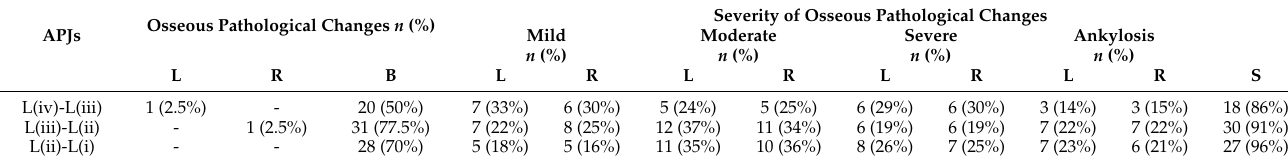
mens (71%) (Figure 6).